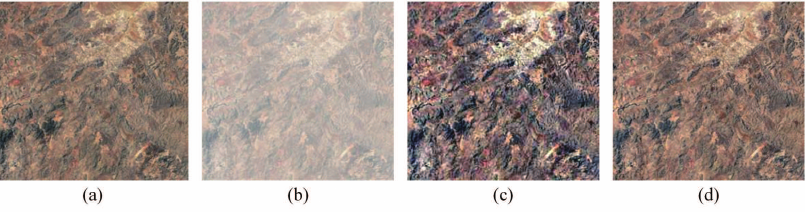
Figure 1. A remote sensing image dehazing example; ( a ) a haze-free image; ( b ) a synthetic hazy image; ( c ) a dehazed synthetic image obtained by a haze-lines-based method [7]; ( d ) a dehazed synthetic image obtained by the proposed